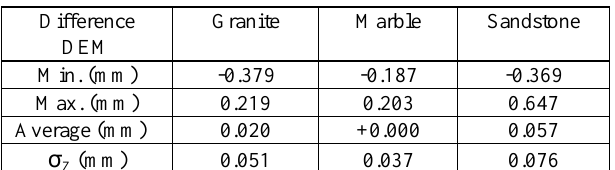
Figure 7. Difference DEM in oblique view and histogram of difference values before-after a large flow event at the Erlenbach field